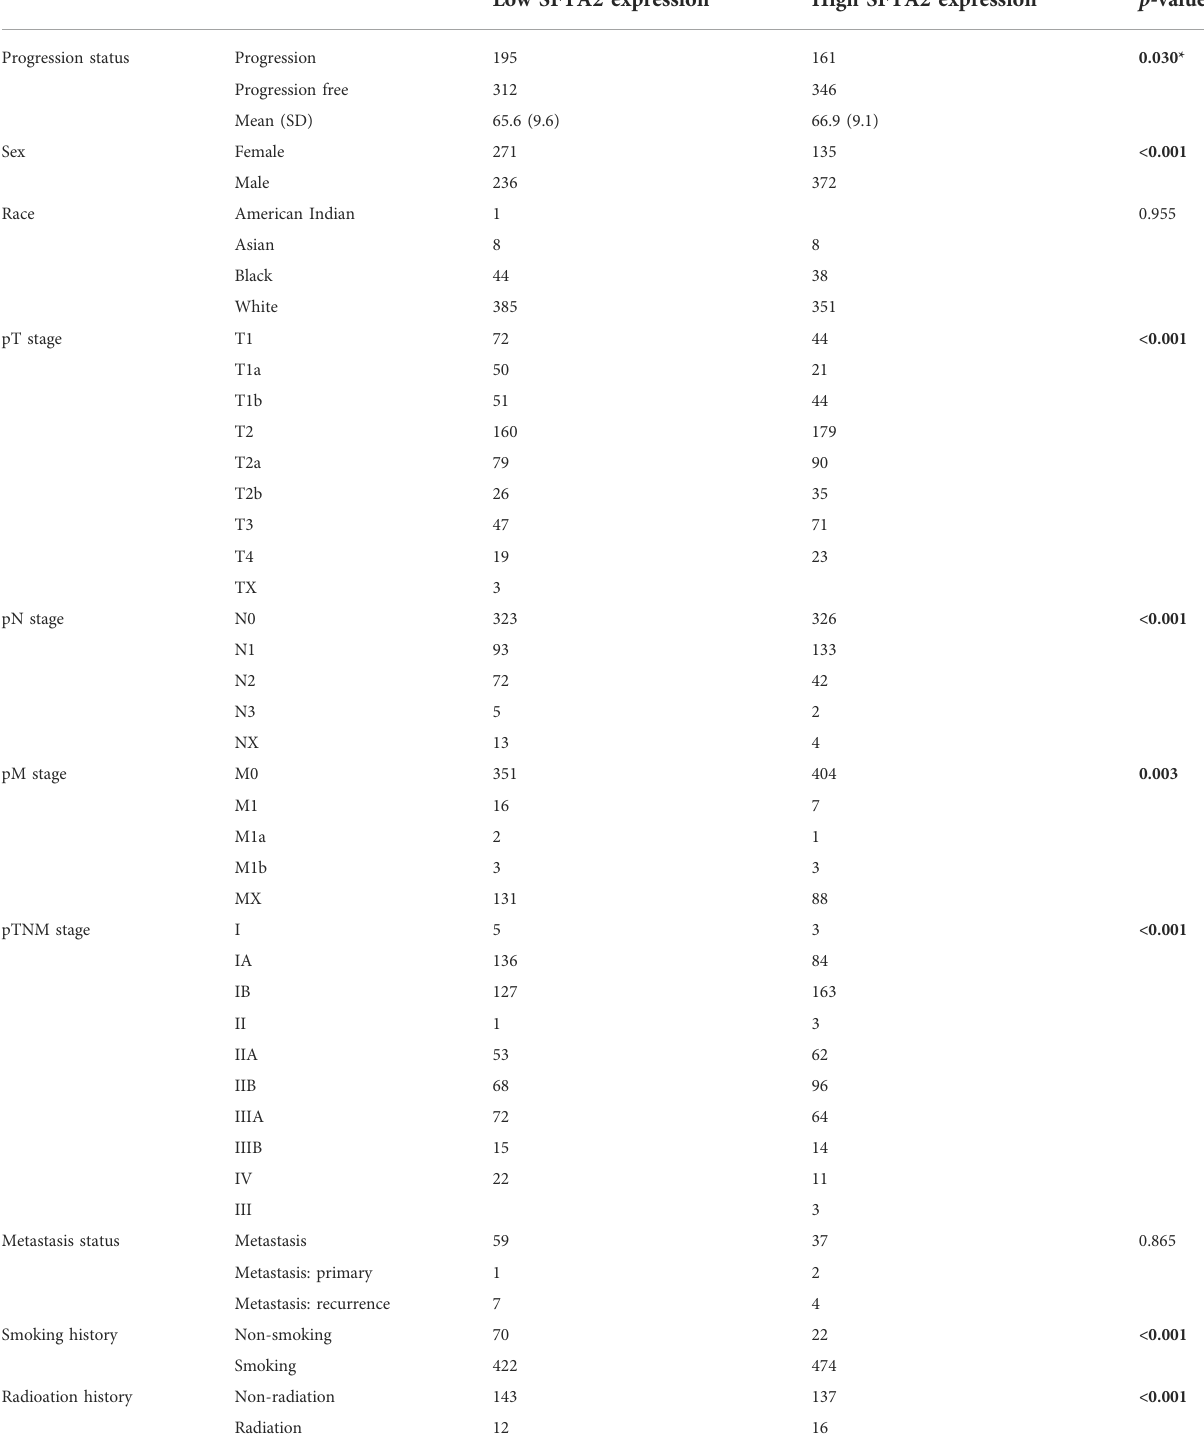
TABLE 2 Clinical and pathological features according to the differential SFTA2 expression in 1,000 NSCLC patients from the TCGA